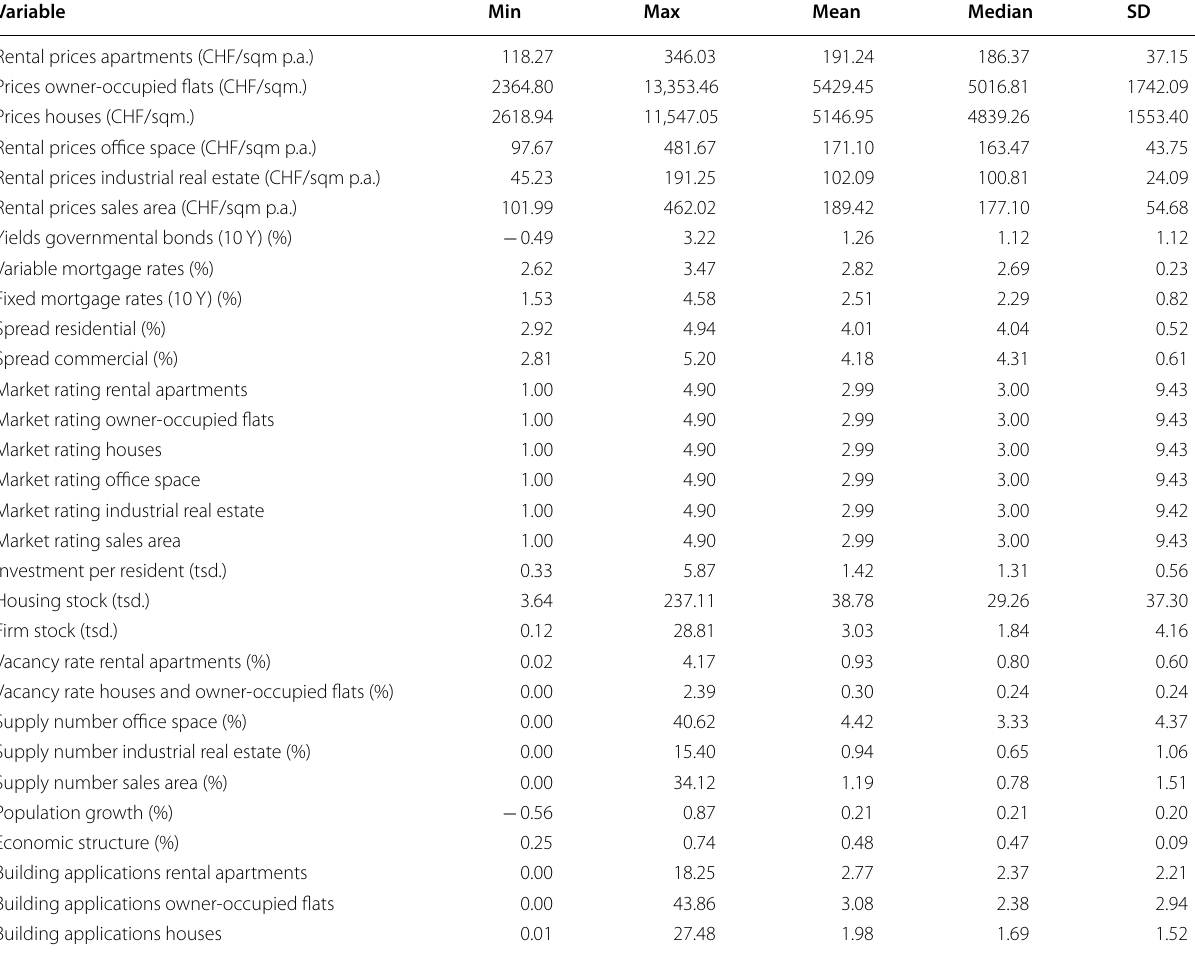
All displayed values reflect variations across 106 MS-regions of Switzerland between 2005 Q1 and 2018 Q4. Fixed mortgage interest rates are only available for a limited time frame between 2008 Q1 and 2018 Q4